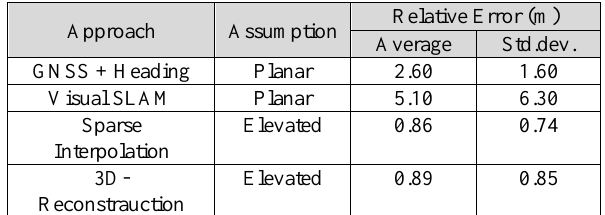
Figure 11: Four maps generated by different agents in urban